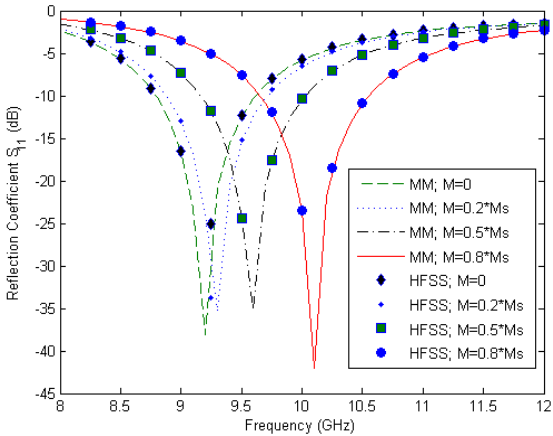
Figure 6. Reflection coefficient of circular waveguide antenna in Figure 3.